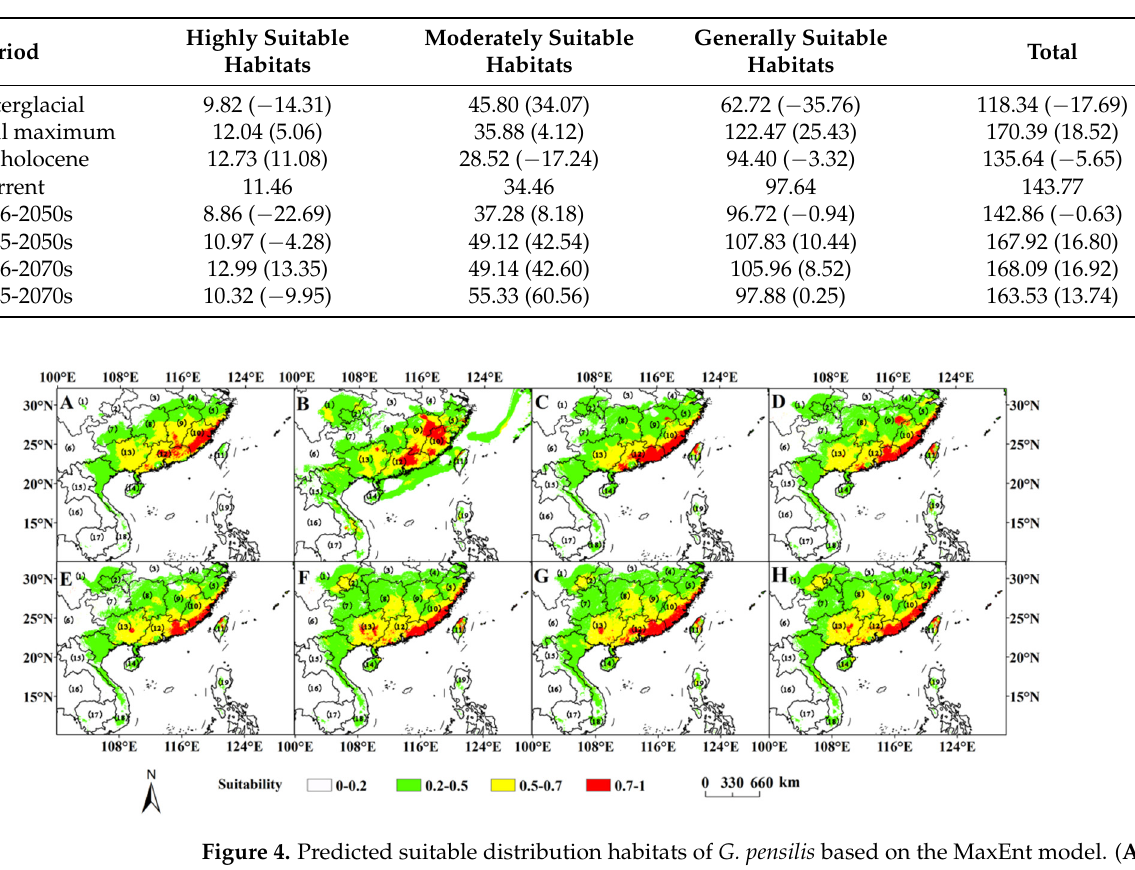
Table 2. Changes of the suitable area of G. pensilis in different periods (unit: ×10 4 km 2 ). Values in parenthesis represent proportion of areas (%).